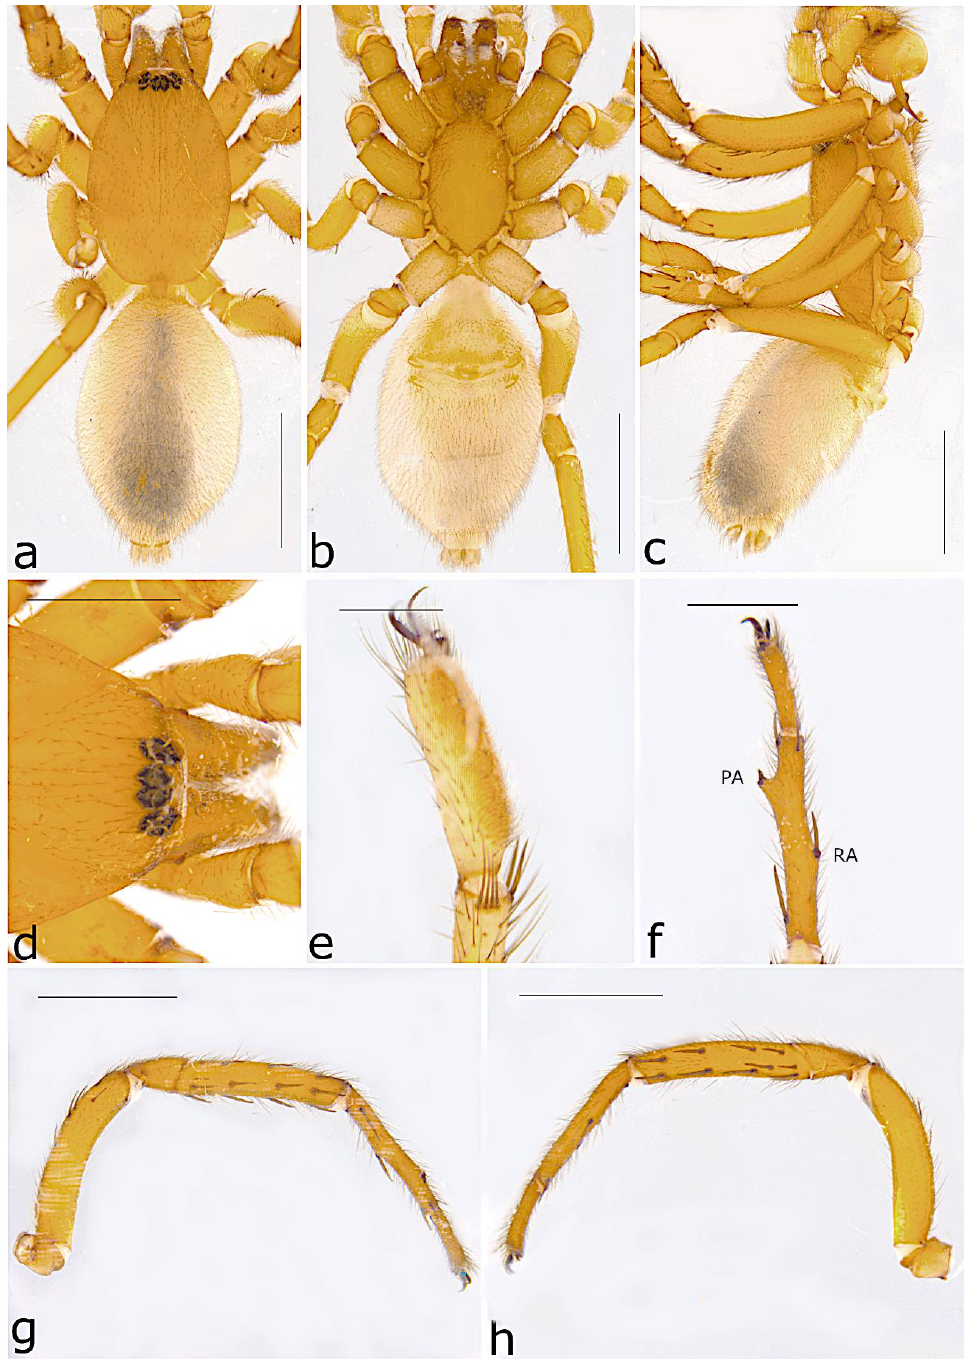
Figure 37. Ariadna flavescens sp. nov. ♂ holotype (SAMA NN30483) from north Arckaringa Creek (SA): ( a ) habitus dorsal view; ( b ) same, ventral view; ( c ) same, lateral view; ( d ) eyes, dorsal view; ( e ) left metatarsus IV, preening comb, retrolateral view; ( f ) left leg I, ventral view; ( g ) same prolateral view; ( h ) same, retrolateral view. Scale bars ( a – c , g , h ) = 2 mm, ( d ) = 1 mm, ( e ) = 0.5 mm, ( f ) = 1 mm and ( g , h ) = 2 mm.